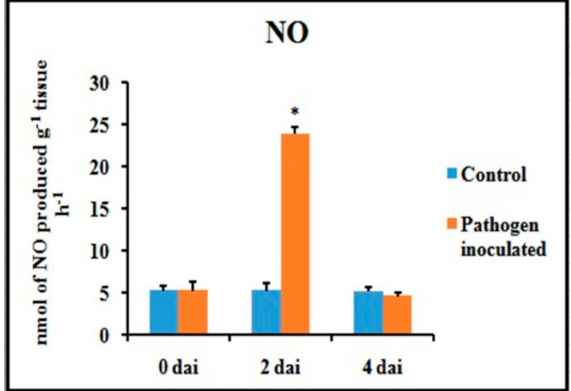
Figure 6. E ff ect of C. gloeosporioides on nitric oxide (NO) production in detached bean leaf. Values represent mean ± SD of three separate experiments, each in triplicate. * Significant di ff erence between pathogen-inoculated and control sets at P < 0.05 .